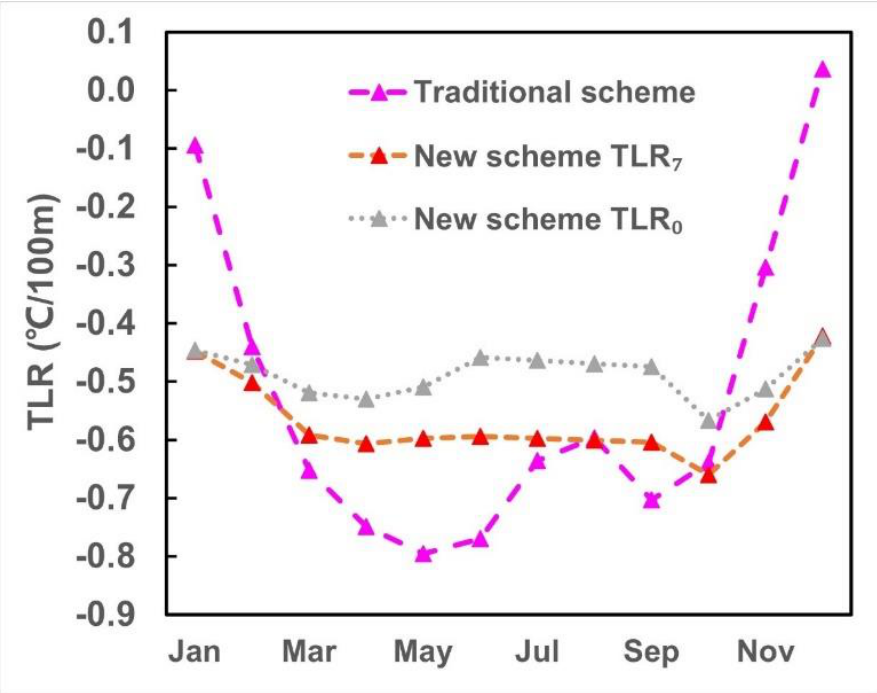
Figure 5. Comparison of monthly TLRs estimated using the traditional scheme and the new scheme. TLR 0 and TLR 7 mean the starting buffer used in the new TLR scheme was buffer No. 0 and No. 7, respectively.